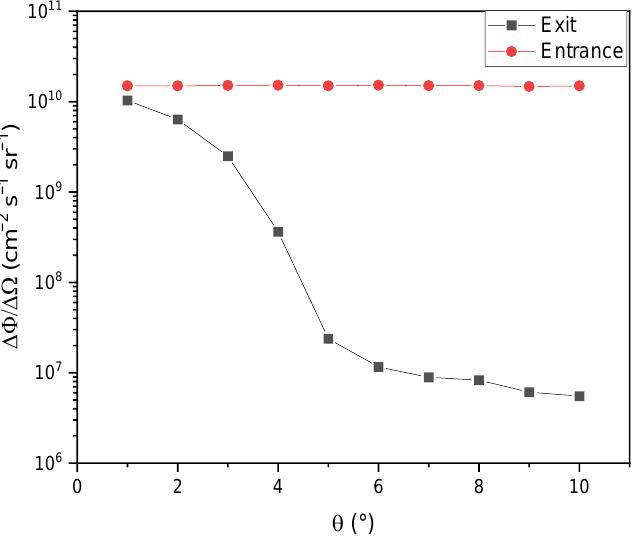
Figure 10. Thermal neutron brilliance at the entrance and exit of the neutron channel.